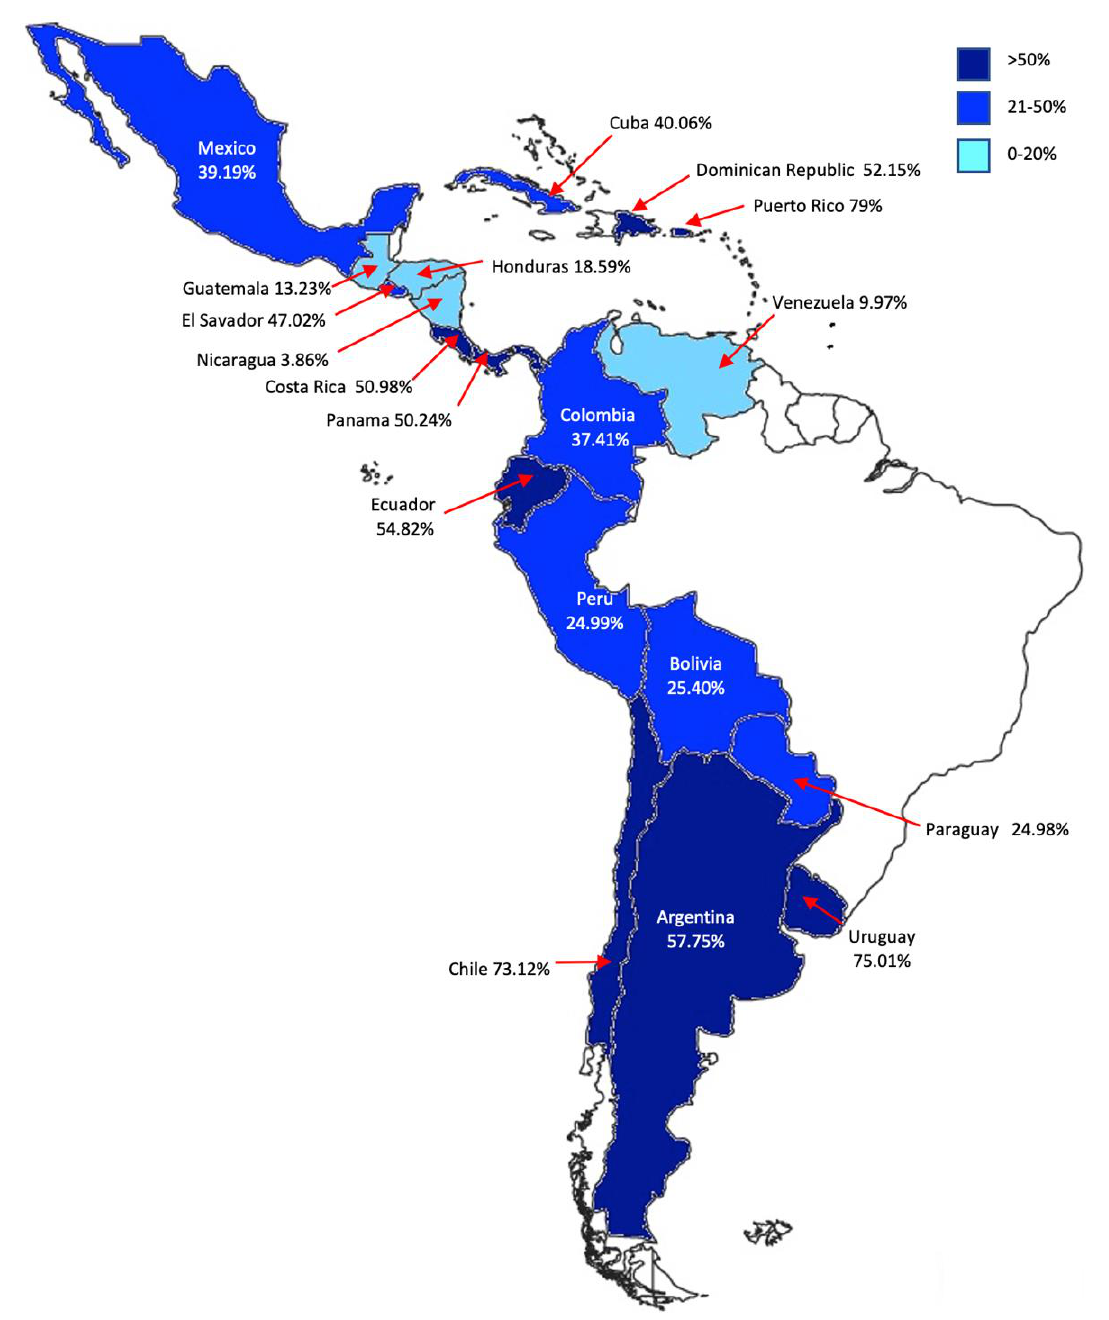
Figure 1. Percentage of the population vaccinated with at least one dose of a COVID-19 vaccine in Spanish-speaking countries in Latin America as of 7 August 2021, based on the vaccination data provided by Mathieu et al. [30].